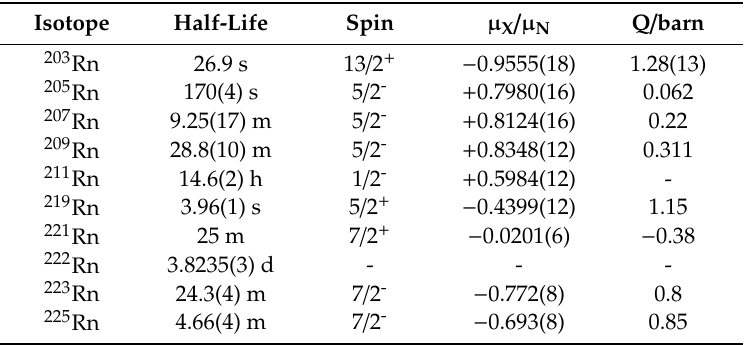
Table 7. Electromagnetic properties of radon